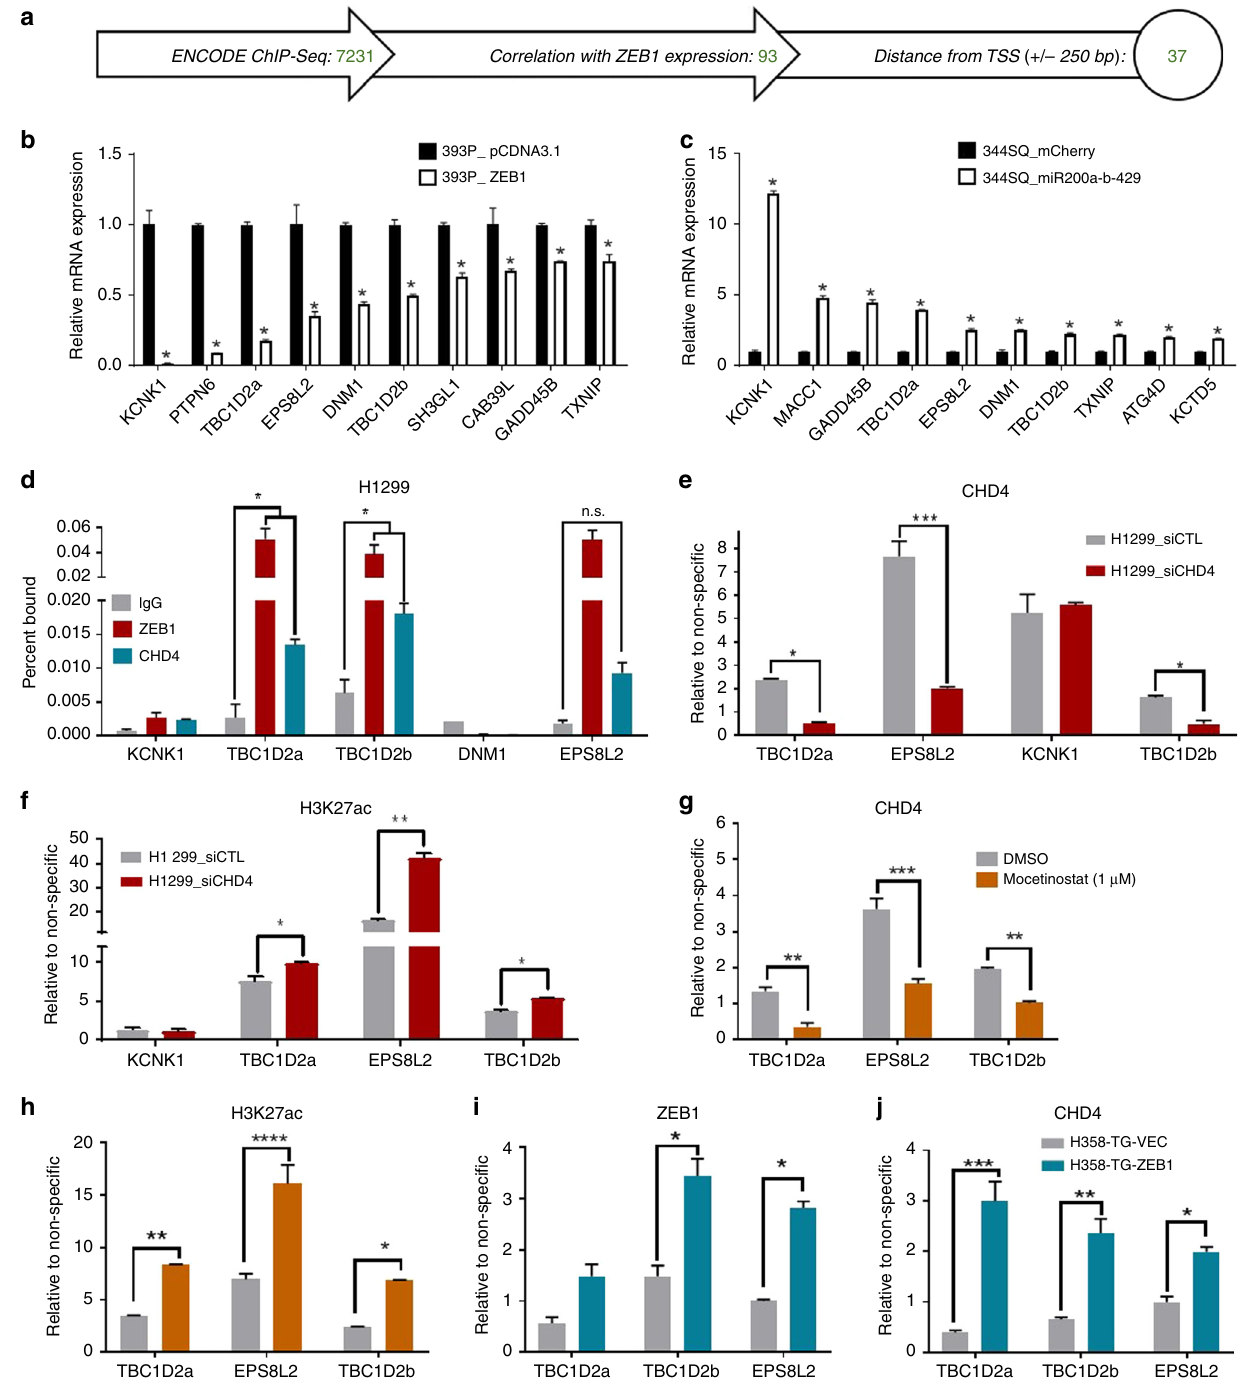
Fig. 4 De fi ning targets of a ZEB1/CHD4/NuRD complex. a Flow chart depicts the criteria for choosing 37 candidate ZEB1/HDAC co-repressor complex target genes from ENCODE ChIP-sequencing data. Brie fl y, the ENCODE ChIP-seq data for ZEB1 and CHD4 was mined for potential co-binding. The list was re fi ned by various mRNA datasets to identify targets which inversely correlate with ZEB1 expression. Lastly, ZEB1 binding ( − / + 250bp) was applied as ZEB1 preferentially binds to this region. Validation of ZEB1/CHD4/NuRD targets was initially determined by comparison of mRNA in b 393P constitutively expressing ZEB1 and c 344SQ inducibly expressing miR200a-b-429; all asterisks indicate statistical signi fi cance by t -test ( n ≥ 3, *p ≤ 0.005); error bars represent standard error mean. d ChIP-qPCR in the human NSCLC cell line H1299 con fi rm that ZEB1 and CHD4 co-occupy the promoter of KCNK1, TBC1D2, TBC1D2b and EPS8L2, as compared to non-speci fi c IgG control. e Transient depletion of CHD4 in H1299 decreases CHD4 binding, but increases H3K27 acetylation ( f ) at the promoters of TBC1D2a, TBC1D2b, and EPS8L2. g CHD4 and (H) H3K27ac ChIP was performed in the cell line H1299 after 24 h treatment with mocetinostat (1 μ M). Relative CHD4 binding decreased upon treatment, while H3K27 acetylation increased. j ZEB1 overexpression in H358 signi fi cantly enhances both ZEB1 and i CHD4 binding to TBC1D2b and EPS8L2. Enrichment in ChIP experiments are relative to non-speci fi c IgG control at each locus and is presented as the mean + / − standard error mean from three independent experiments; all asterisks indicate statistical signi fi cance by t -test ( n ≥ 3, * p ≤ 0.05); error bars represent standard error mean NATURE COMMUNICATIONS| (2019) 10:5125